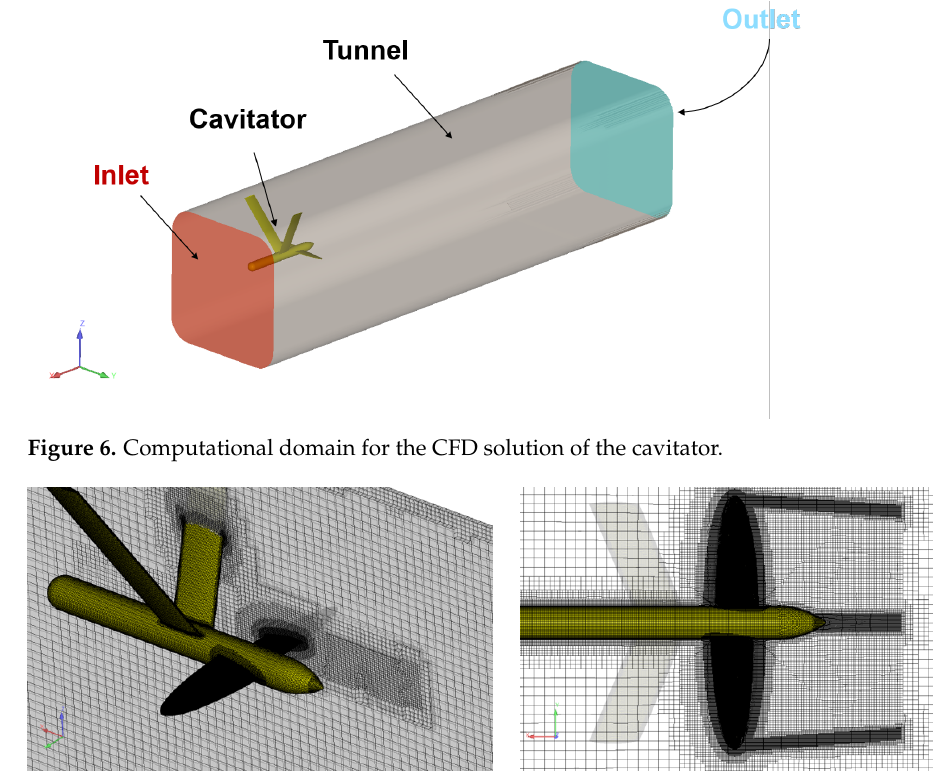
Figure 7. Views of the computational grid for the CFD solution of the